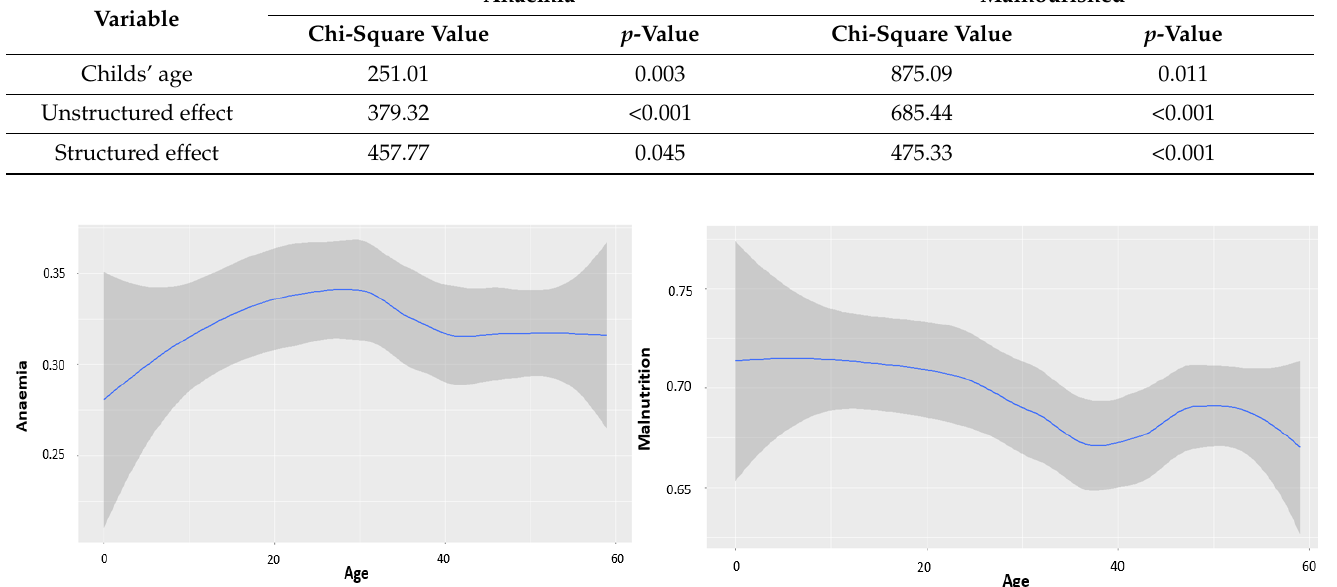
Figure 3. Estimated non-linear effect of the child’s age on anaemia and malnourishment. Table 6. Approximate significance for the spatial and non-linear effects.